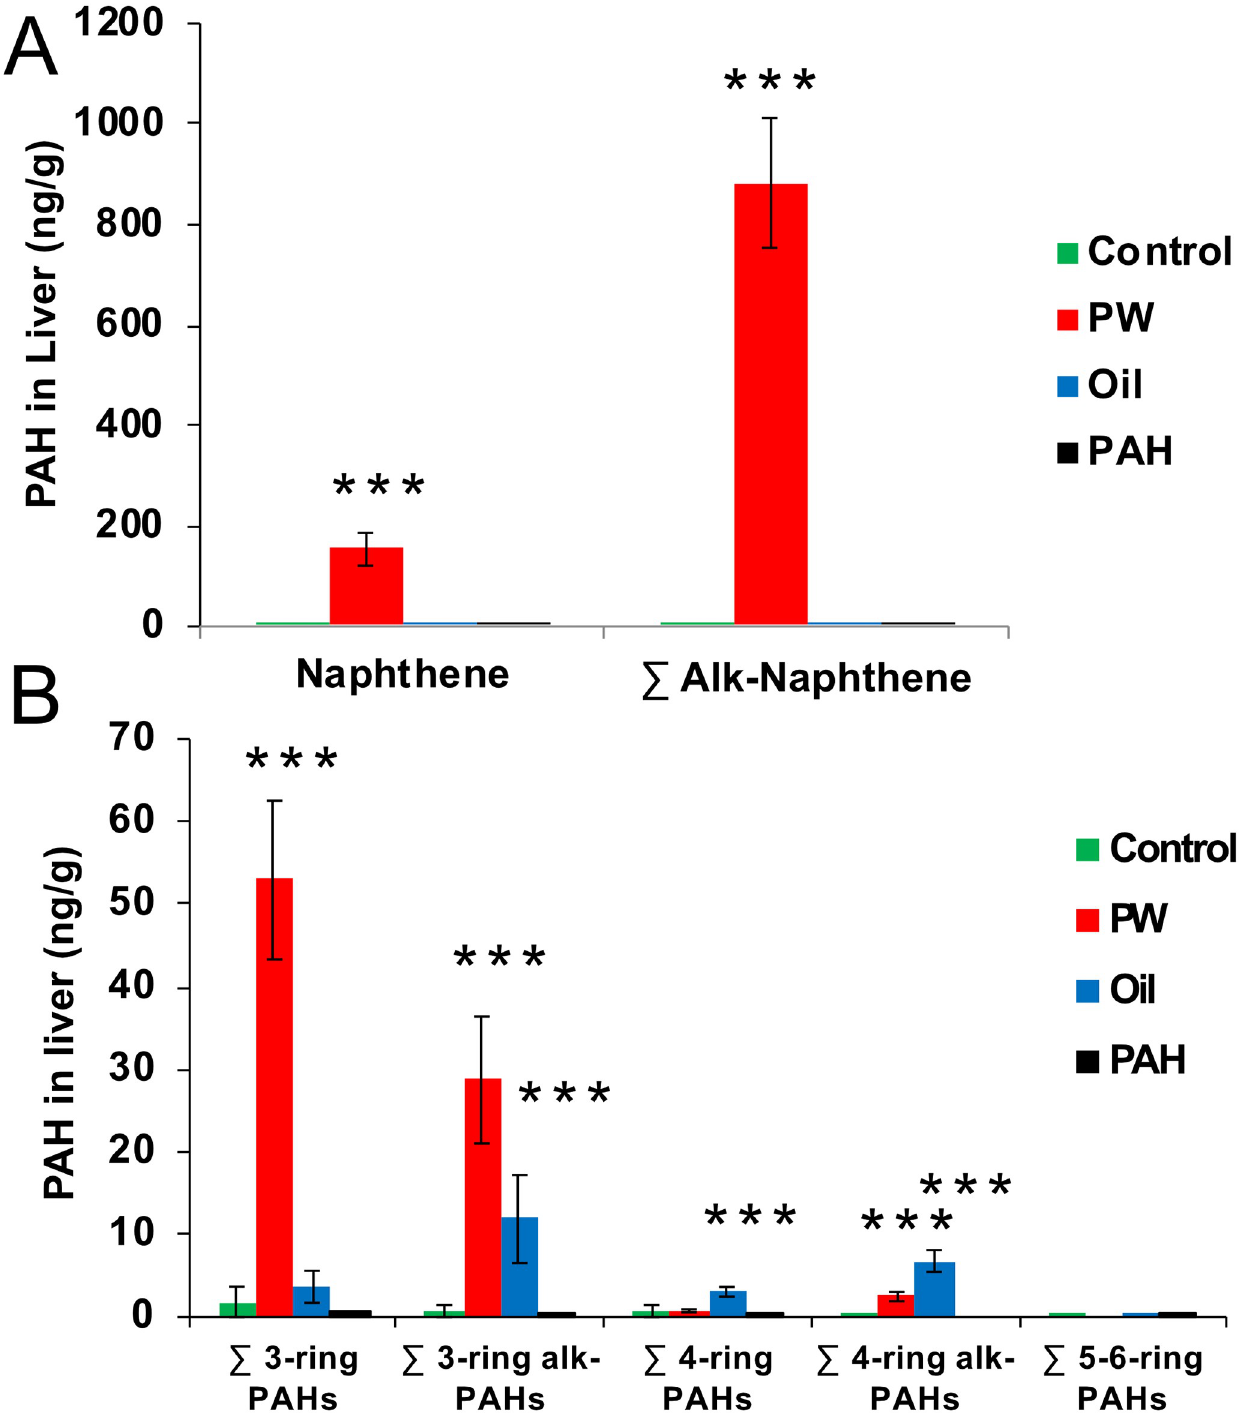
Fig 7. PAH found in the liver (ng/g) of the different treatments groups after 67 days of oral exposure. A. Naphthalene and sum alkylated naphthalenes. B. Sum 3-6-ring PAHs and their alkylated forms. Data presented as means ( ± SD). Asterisks indicate statistical difference relative to the control fish (ANOVA). P < 0.001 = ���